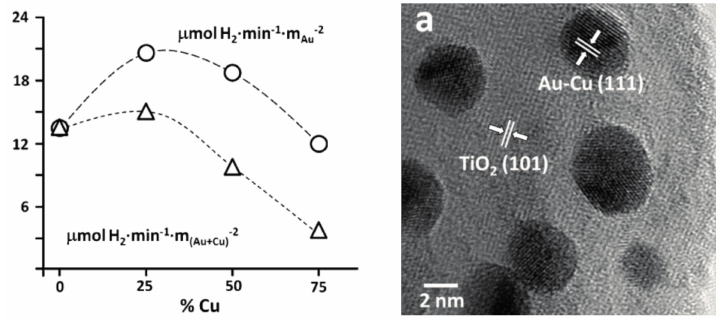
Figure 11. The enhanced activity of Cu/Au—TiO 2 NPs in photocatalytic hydrogen production ( left ); the high-resolution transmission electron microscopy (HR-TEM) micrograph of the used composite material ( right ). (Reproduced with permission from Reference [152] published by